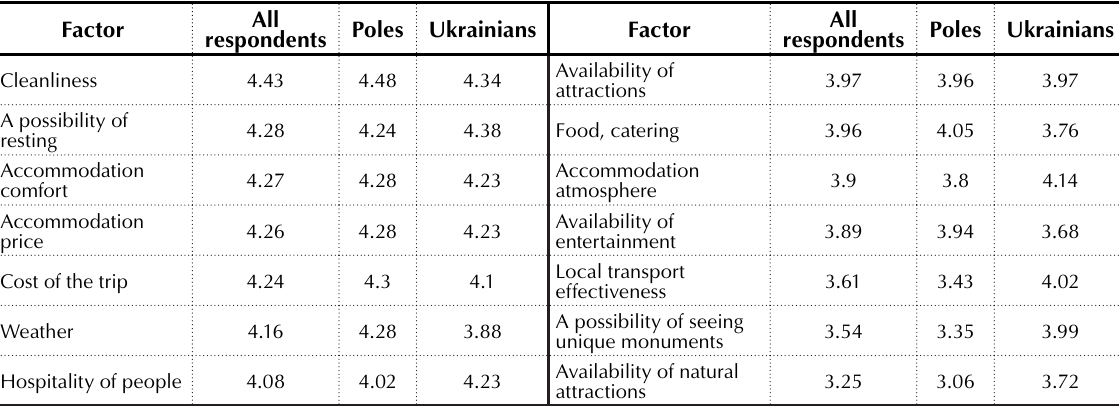
Source: Own work based on the survey